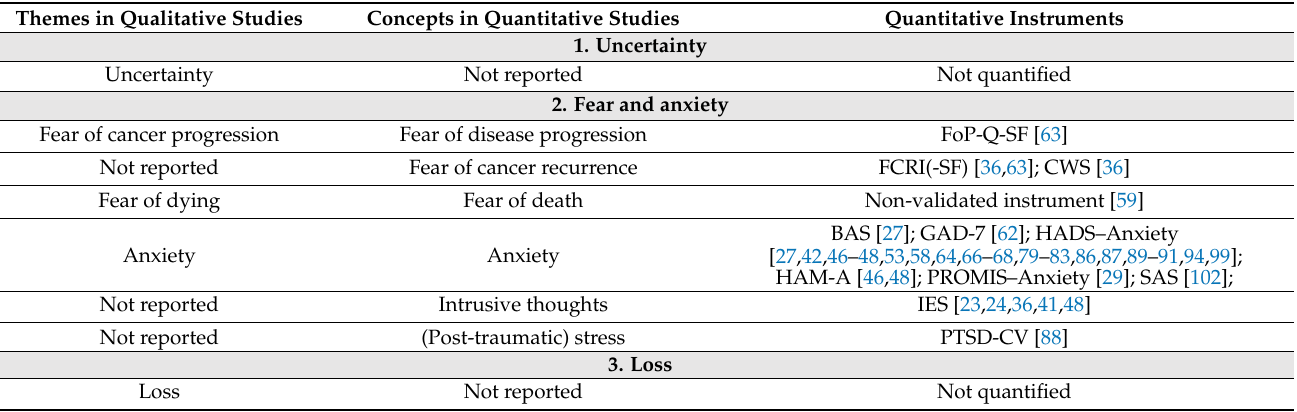
Table 1. Overview of psychosocial themes, concepts, and